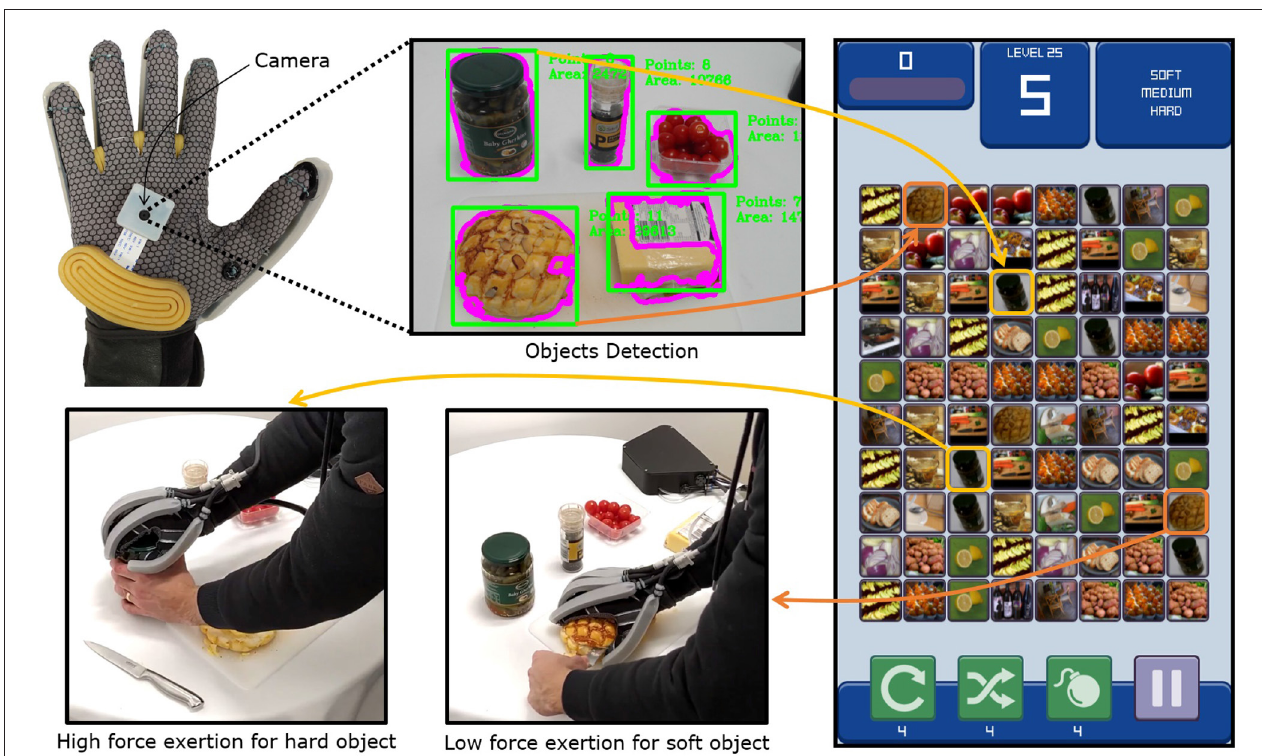
FIGURE 3 | Information flow in the exoskeleton glove control enhancement experiment. The camera mounted on the exoskeleton glove captures the scene image, where object bounding boxes are detected through edge detection and contour extraction. The unknown object images are submitted for labeling to the server, within the “stiffness” attribute group. The server generates game instances where the players connect objects that share the same stiffness attribute (“soft,” “medium,” “hard”). Player matches are aggregated and the assigned stiffness attributes of unknown objects are returned to the glove. As the glove gets pre-positioned above an object, the object image is linked to the labeled results by comparing its ORB ( Rublee et al., 2011) descriptors. When the user attempts to grasp an object and occludes the palm camera, the glove triggers a grasp that exerts an appropriate amount of force on the object, with respect to its